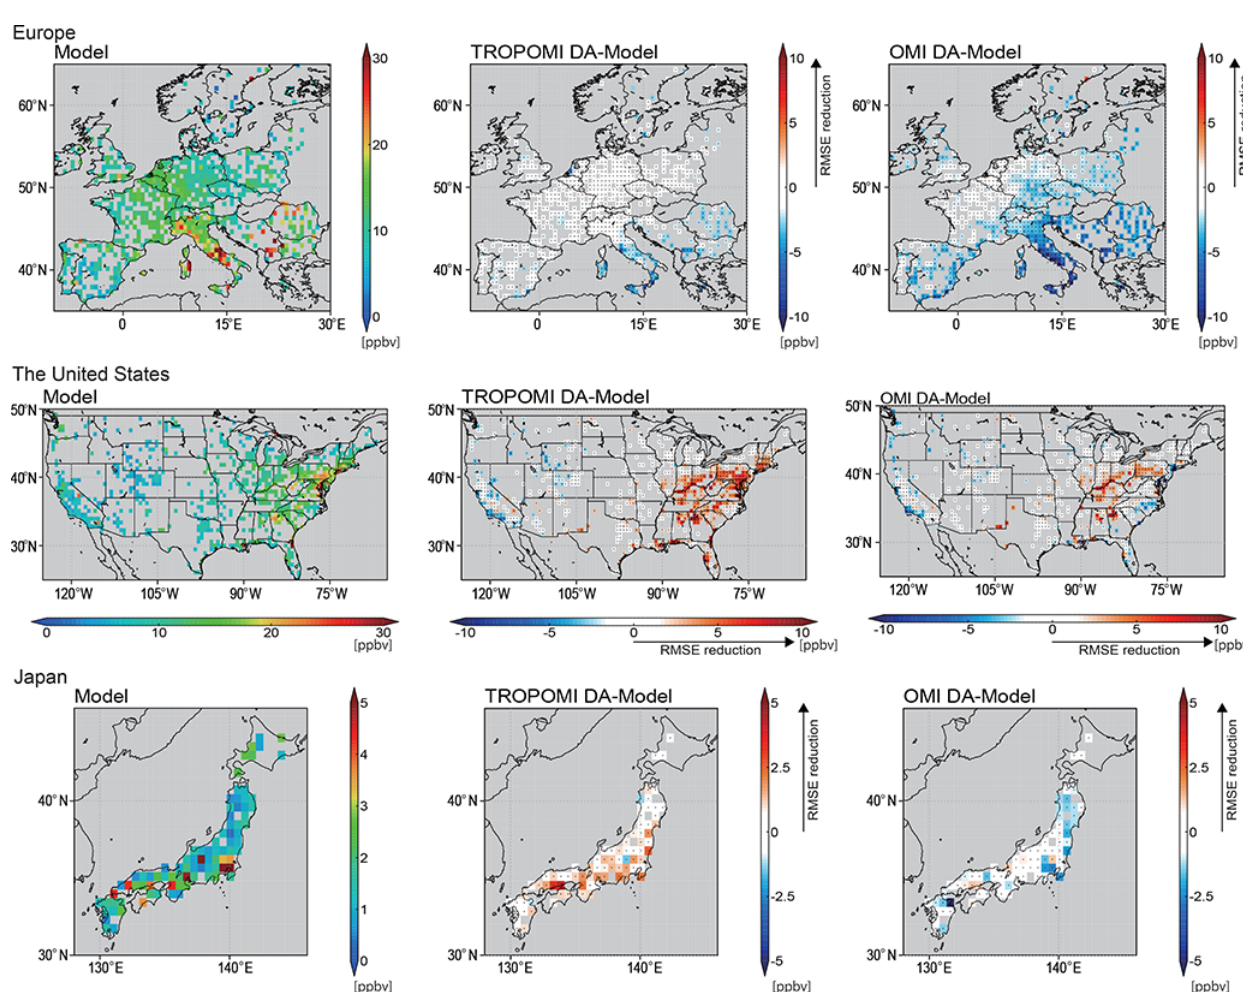
Figure 10. Root-mean-square errors (RMSEs) against surface in situ observations (ppbv) for daily maximum 8h average (MDA8) ozone concentrations in the control model simulation (left), as well as their reductions by Tropospheric Monitoring Instrument (TROPOMI) data assimilation (DA) and Ozone Monitoring Instrument (OMI) DA (middle and right, respectively) over Europe (top), the United States (middle), and Japan (bottom). The values are mapped onto 0.56 ◦ resolution grids. For the middle and right columns, grids with open circles indicate the RMSE reductions that are statistically significant at the 95% confidence level using the Mann–Whitney U